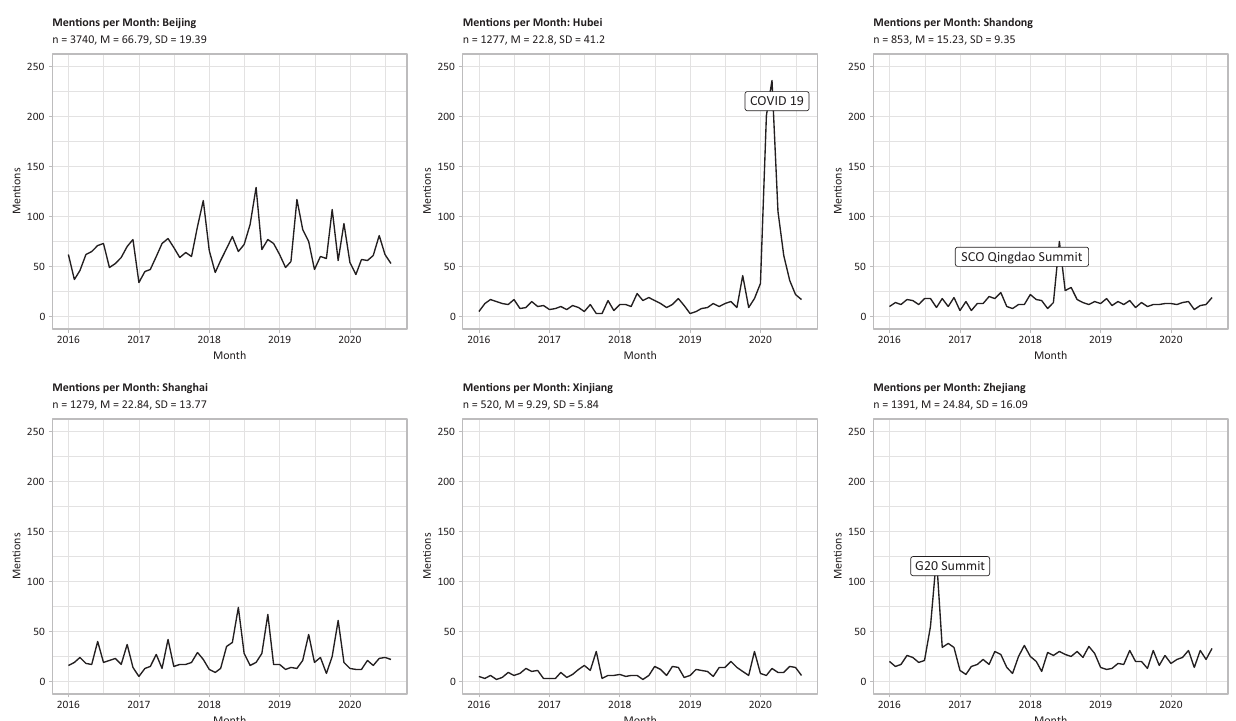
Figure 5. Articles per month for selected locations. Note: Major events are labeled where appropriate. weak correlation with population in domestic coverage, indicating that in international coverage, People’s Daily may function more in line with other news organizations around the